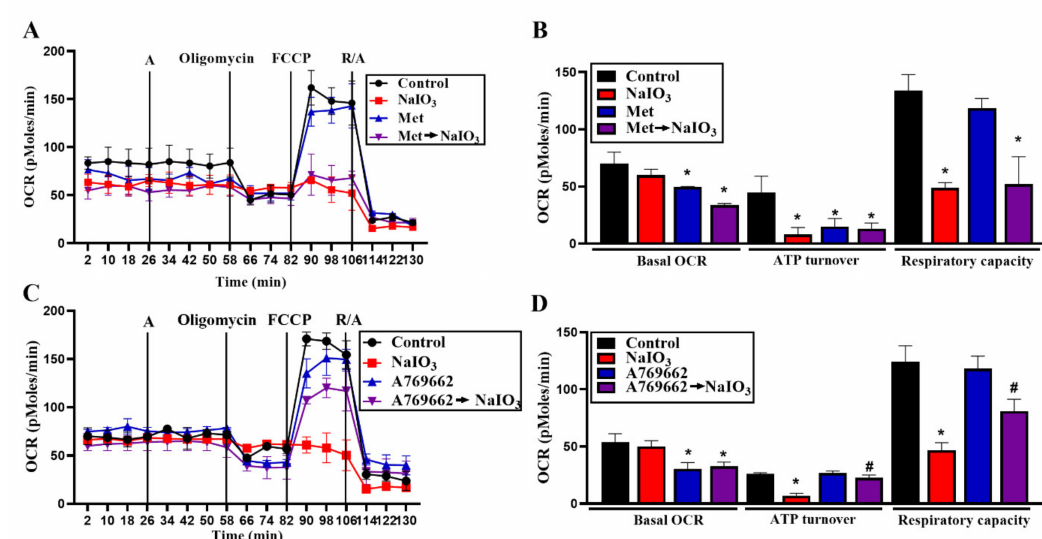
Figure 3. A769662, but not metformin, reverses the NaIO 3 -induced mitochondrial oxygen consumption rate (OCR) decrease. Metformin (6 mM) ( A ) or A769662 (30 µ M) ( C ) were pretreated 26 min prior to NaIO 3 injection through Port A. Then cells were subsequently treated with oligomycin, FCCP and antimycin A / rotenone. Intracellular OCR was measured by seahorse XF24 analyzer. ( B , D ) Resting OCR, ATP turnover and respiratory capacity were analyzed and the data were mean ± SEM from three independent experiments. * p < 0.05, indicating the significant e ff ects of NaIO 3 . # p < 0.05, indicating the inhibitory e ff ects of A769662 on the action of NaIO 3 .